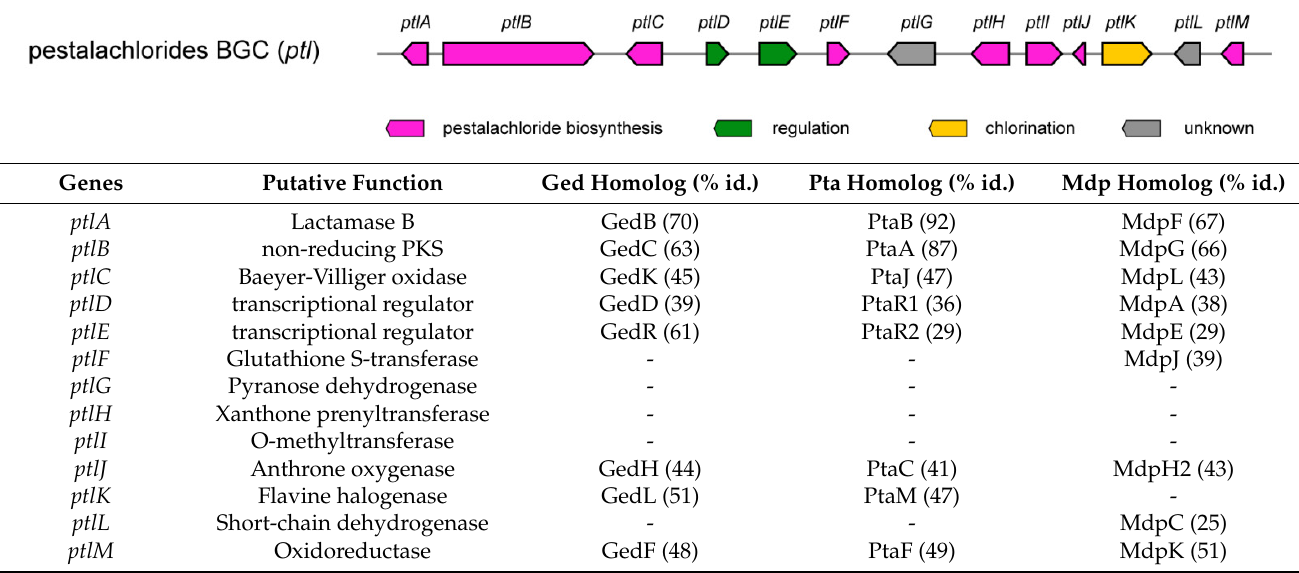
Table 2. Analysis of the pestalachloride biosynthetic gene cluster by comparison with geodin ( ged ),